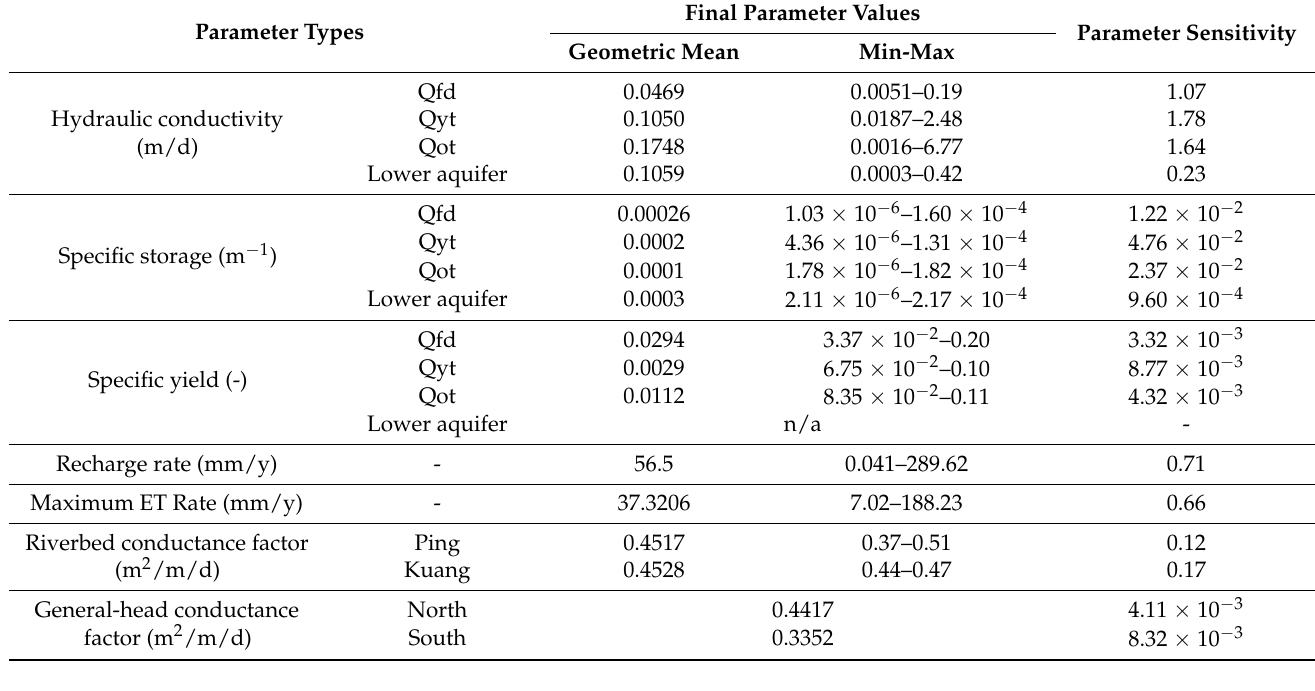
Table 3. Final parameter values after calibration.